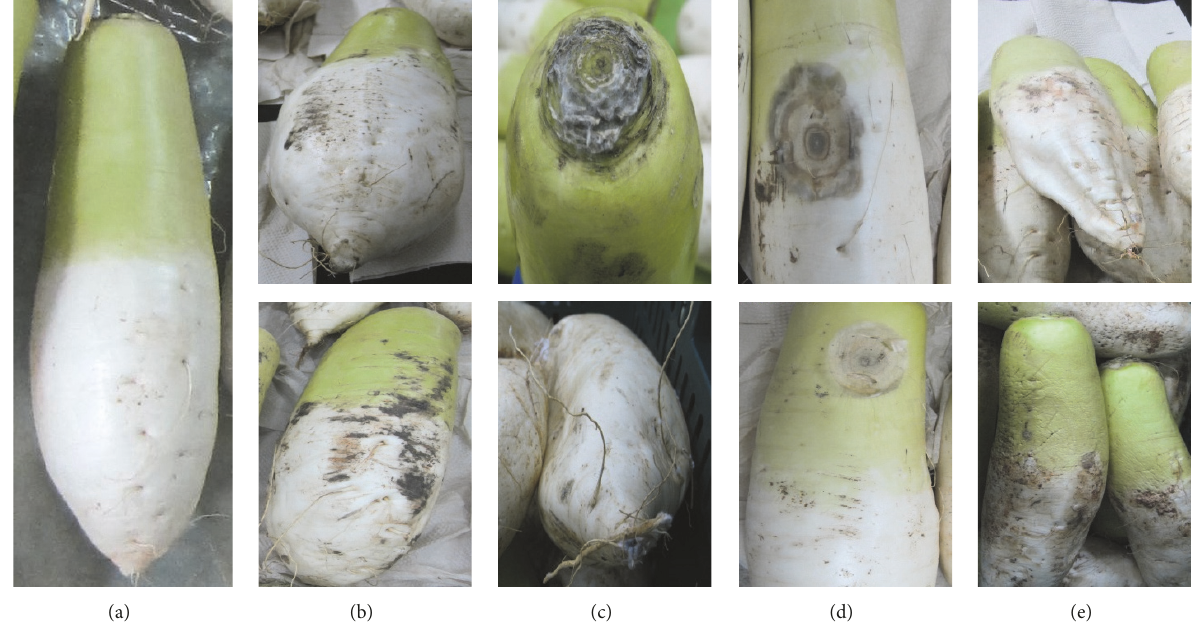
Figure 2: Radish roots with different symptoms observed during storage: (a) fresh radish, (b) black spot incidence, (c) incidence of fungal infection, (d) incidence of decay, and (e) shrinkage due to moisture